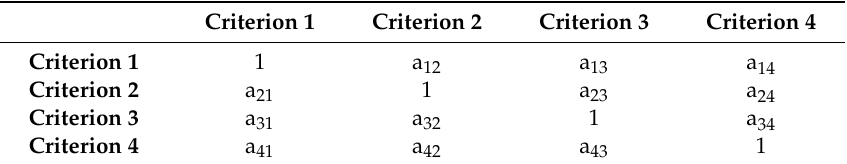
Table 3. Example of comparison matrix for criteria